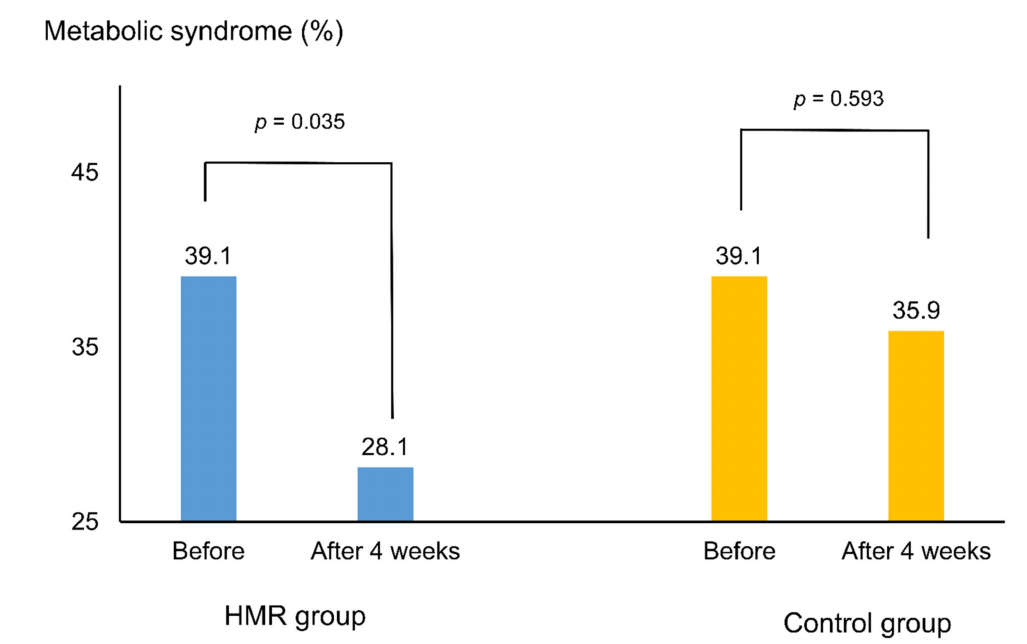
Figure 2. Proportion of subjects meeting metabolic syndrome criteria before and after the intervention according to diet